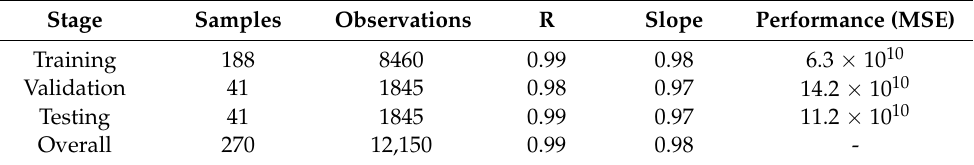
Table 5. Statistical data of the artificial neural network regression model (Model 2) to predict the peak area of volatile aromatic compounds. Performance was assessed based on mean squared error (MSE). Abbreviations: R: correlation